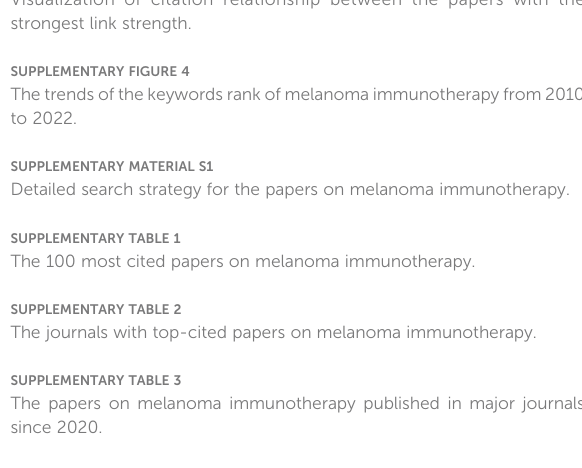
SUPPLEMENTARY FIGURE 1 Historical direct citation network among the papers. SUPPLEMENTARY FIGURE 2 Top 25 references with the strongest citation bursts in papers in melanoma immunotherapy. The green line indicates the timeline, and the intervals in which bursts were found are indicated by red sections on the timeline, indicating the start year, the end year, and the burst duration. SUPPLEMENTARY FIGURE 3 Visualization of citation relationship between the papers with the strongest link strength. SUPPLEMENTARY FIGURE 4 The trends of the keywords rank of melanoma immunotherapy from 2010 to 2022.